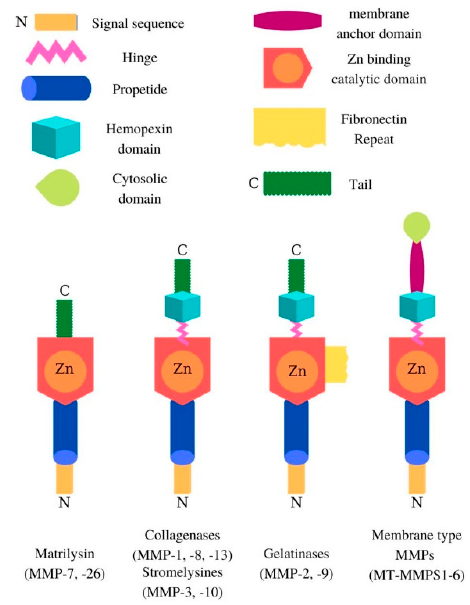
Figure 2. Modular organization of the MMP domain.